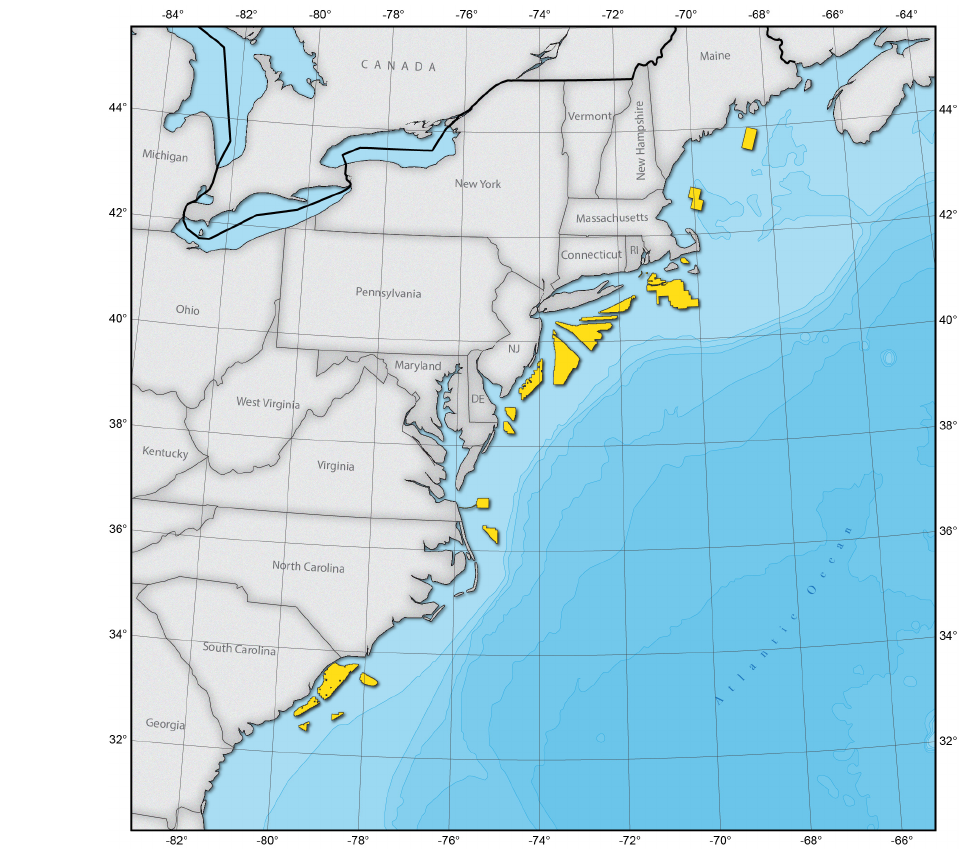
Figure 14. Bureau of Offshore Energy Management lease areas for the US East Coast. Colour codes are used to differentiate different areas.